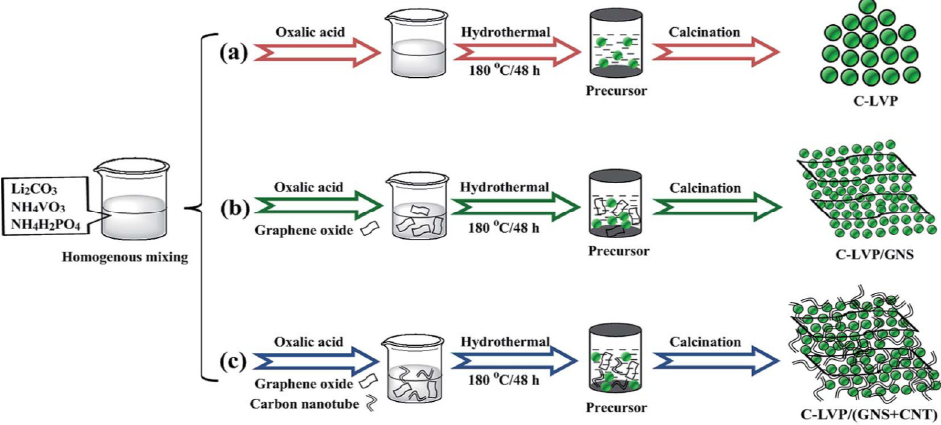
Figure 3. Schematic illustration of preparing nanosized Li 3 V 2 (PO 4 ) 3 /C (C-LVP), carbon nanotube modified Li 3 V 2 (PO 4 ) 3 /C (C-LVP/GNS), graphene nanosheet, and carbon nanotube co-modified Li 3 V 2 (PO 4 ) 3 /C (C-LVP/(GNS+CNT)) composites via a hydrothermal-assisted sol-gel route.